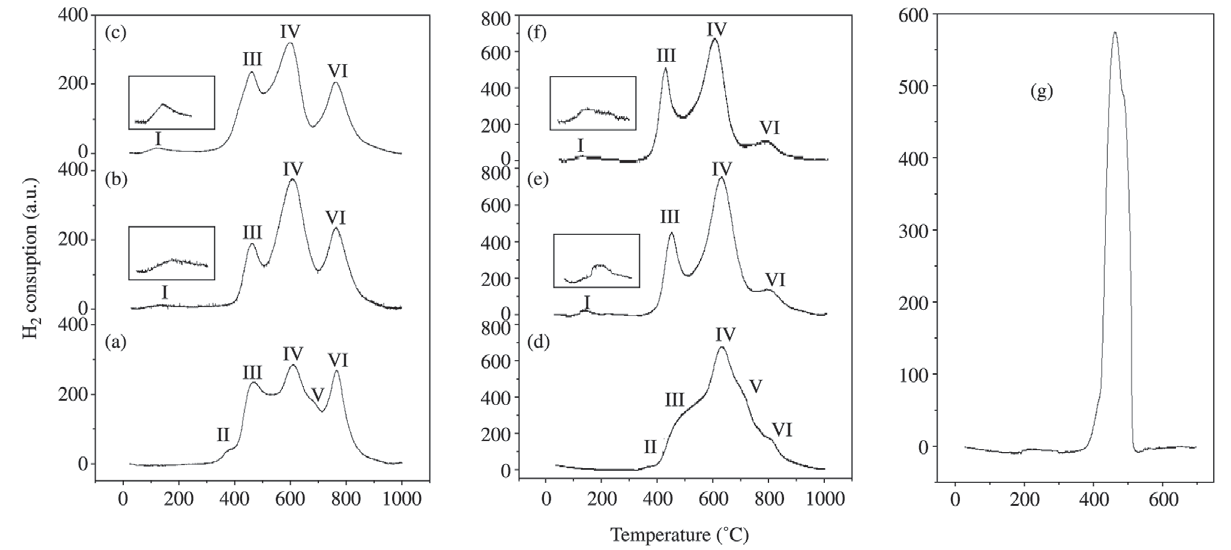
Figure 1. TPR-H2 patterns of catalysts: a) 5Co; b) 0,5Ag/5Co; c) 1Ag/5Co; d) 9Co; e) 0,5Ag/9Co; f) 1Ag/9Co; g) Co